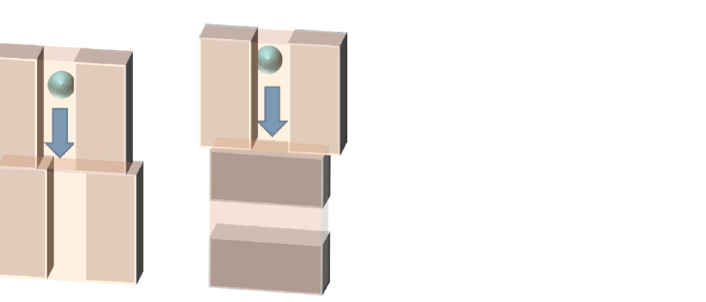
Figure 1. Schematic diagram of the narrowing and obstruction of micropores along the grain